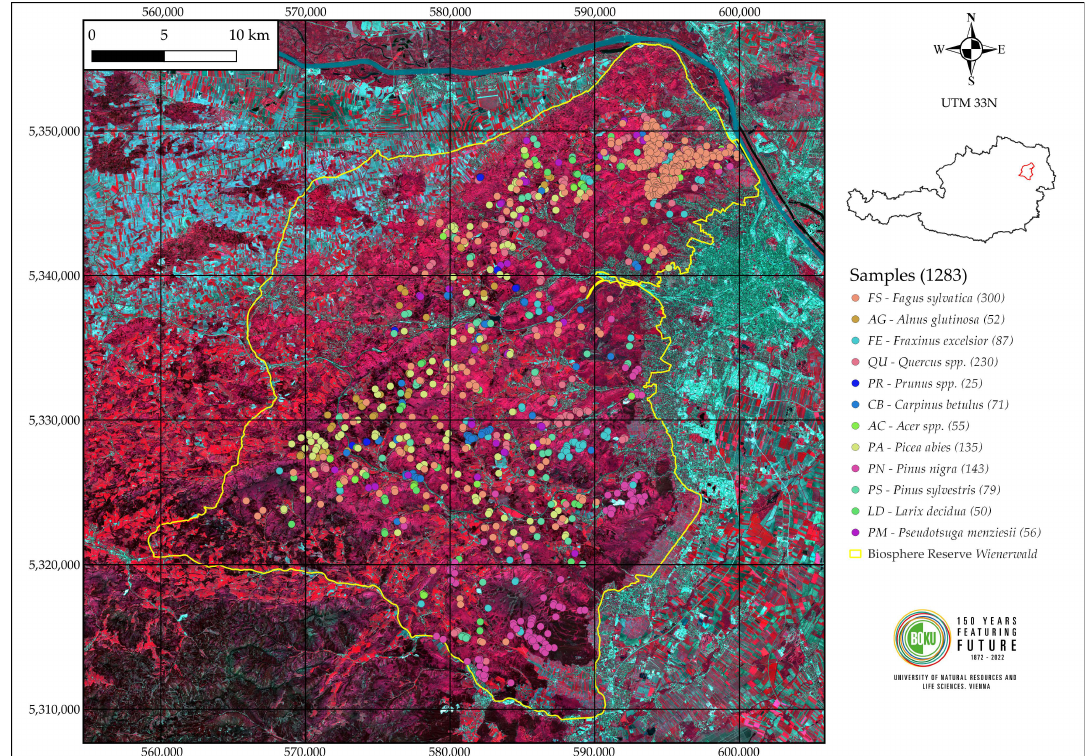
Figure 1. Overview of the Biosphere Reserve Wienerwald in the southwestern area of Vienna as well as the 12 classes of tree species reference samples. Background: Color Infrared composite of Sentinel-2.